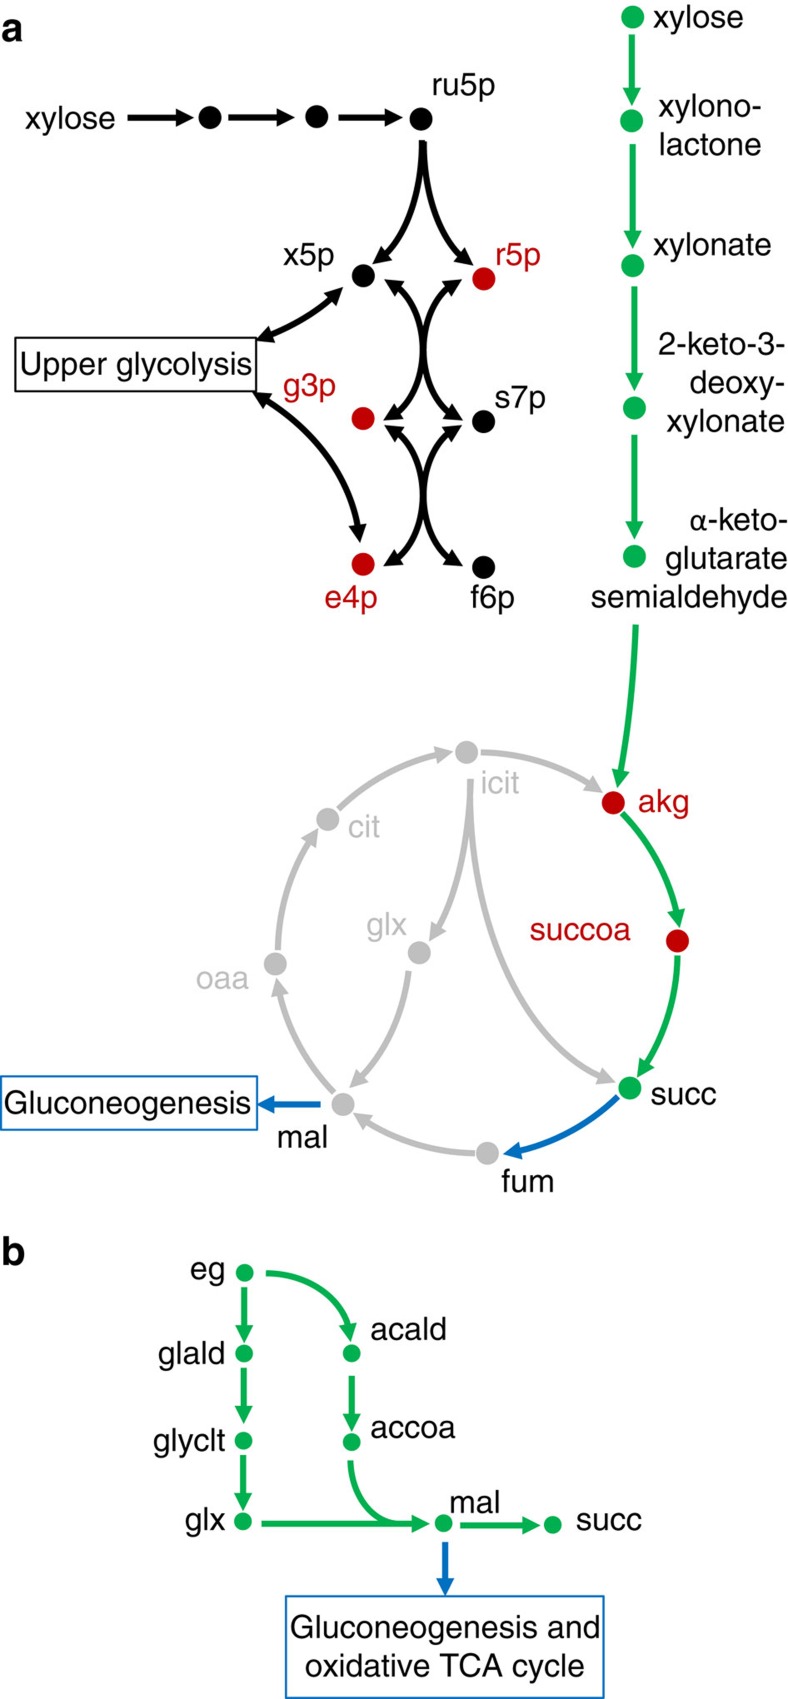
Orthogonal pathway design for other substrates considered in this study.(a) The Weimberg pathway is heterologous to E. coli, however, it provides an efficient route for xylose assimilation that bypasses the central carbon metabolism and most biomass precursor molecules. To the left of the Weimberg pathway is shown the natural route for xylose assimilation in E. coli through the pentose phosphate pathway. Succinate dehydrogenase, which converts succinate to fumarate is an ideal candidate as a metabolic valve (shown in blue) as it allows flux to the TCA cycle and supports gluconeogenic pathways for cell growth. (b) The orthogonal routes for ethylene glycol assimilation examined in this study. Malic enzyme is an ideal candidate for a metabolic valve (shown in blue) as malate decarboxylation to pyruvate can support cell growth. The degree to which the pathway overlaps with the central carbon metabolism is captured by the orthogonality score for each specific pathway.